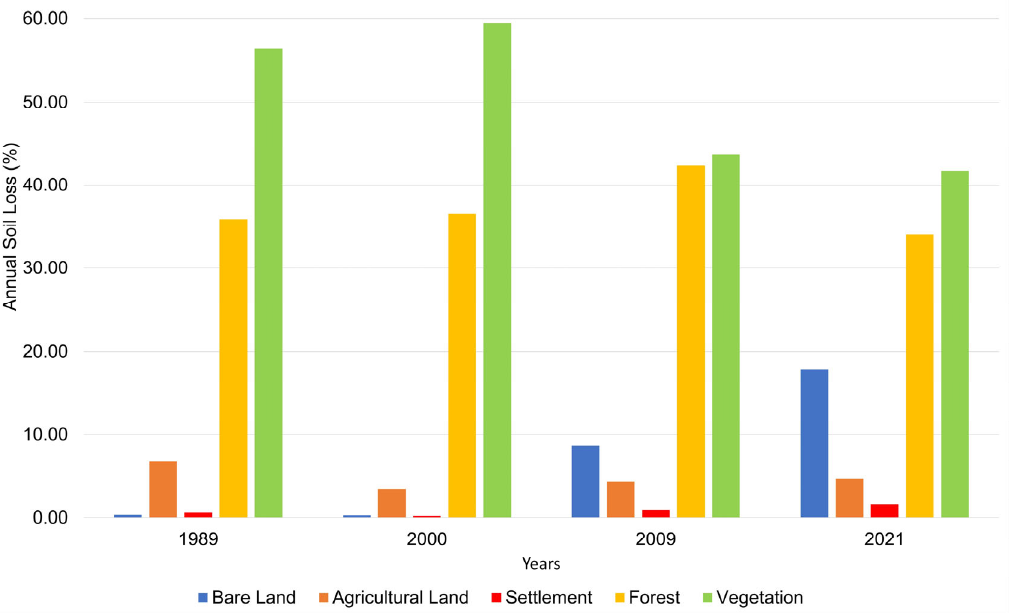
Figure 12. Land use/land cover types and corresponding annual soil loss from 1989 to 2021. The spatially distributed LU/LC conversion from 1989 to 2021 is shown in Figure 13. Table 15 indicates only significant LU/LC changes and their contribution to soil erosion in the MORB from 1989 to 2021. The maximum soil erosion rate of 8.43 t ha − 1 yr − 1 occurred when forest cover converted into bare land and the average annual soil loss of forest to bare land was 35327.34 tons (7.23%), while the minimum mean soil erosion of 0.61 t ha − 1 yr − 1 occurred when vegetation converted into settlements and 2630.94 tons (0.54%) of average annual soil loss was estimated. The highest soil erosion rates of 6.85 t ha − 1 yr − 1 , 6.04 t ha − 1 yr − 1 , 5.82 t ha − 1 yr − 1 , and 5.31 t ha − 1 yr − 1 occurred when settlement, agricultural land, vegetation, and water bodies converted into bare land, respectively, and their average annual soil loss was 5608.33 tons (1.15%), 13926.35 tons (2.85%), 22148.77 tons (4.53%), and 1750.52 tons (0.36%), respectively. The highest amount of soil loss, 78147.25 tons (16%), occurred when forest cover was converted into vegetation with a 5.25 t ha − 1 yr − 1 mean erosion rate. Table 15. Primary Conversions of LU/LC types in MORB from 1989 to